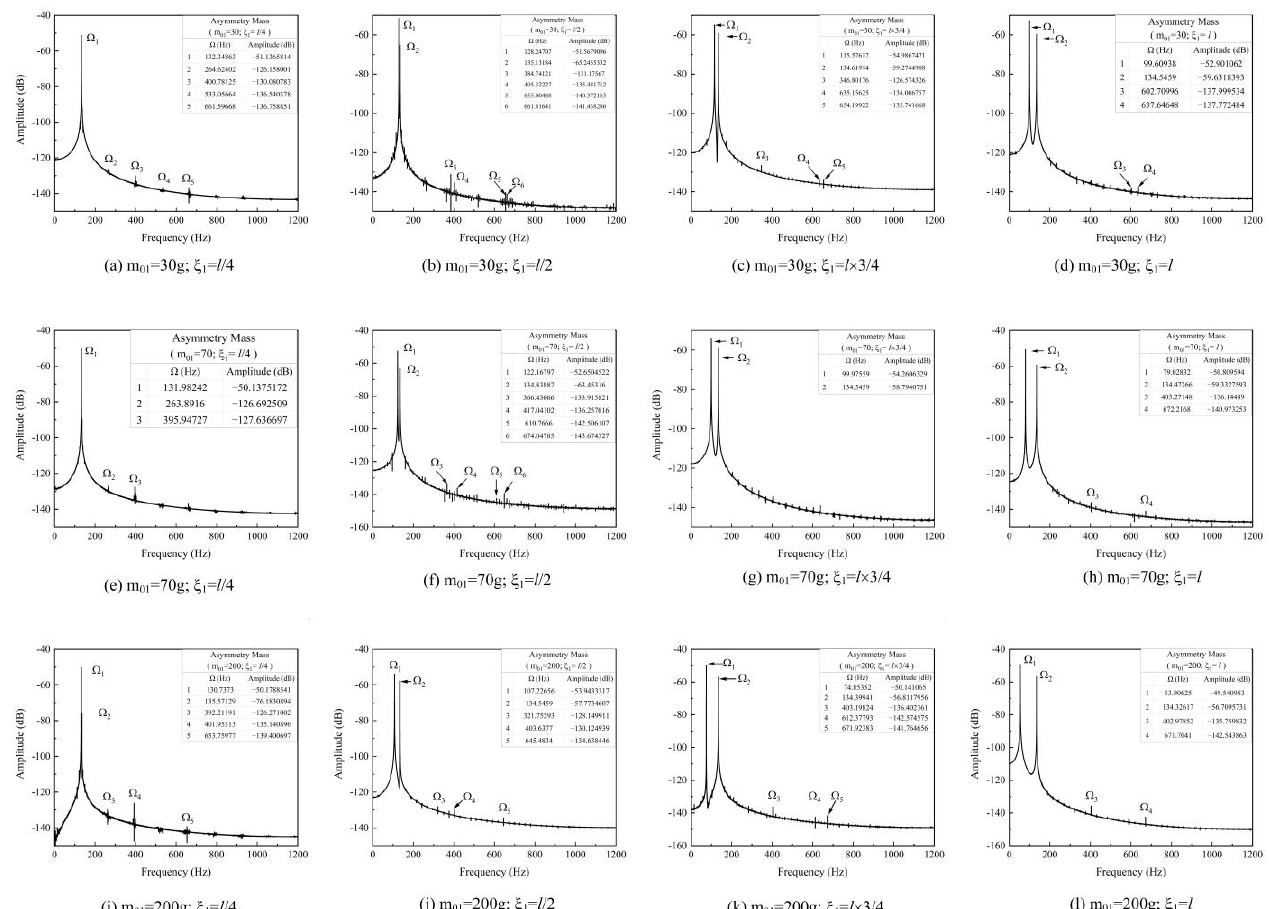
Figure 6. Response spectrogram of coupled vibration model of double beams with asymmetric additional mass. ( a – d ) Asymmetric additional masses in beam 1 (m 01 = 30 g) with different locations (left to right: l /4, l /2, l × 3/4, and l ). ( e – h ) Asymmetric additional masses in beam 1 (m 01 = 70 g) with different locations (left to right: l /4, l /2, l × 3/4, and l ). ( i – l ) Asymmetric additional masses in beam 1 (m 01 = 200 g) with different location (left to right: l /4, l /2, l × 3/4, and l ).